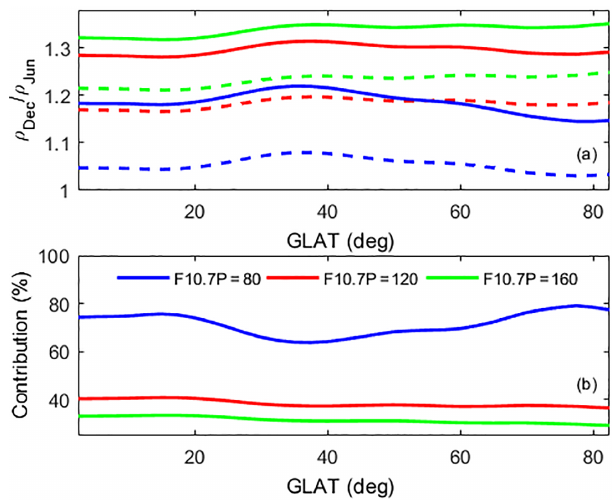
Figure 5. (a, b) The relative amplitudes and (c, d) phases of annual (solid line) and semiannual (dashed line) components from (a, c) the GOCE observations and (b, d) the MSISE00 results at dawn LST under different solar activity conditions.